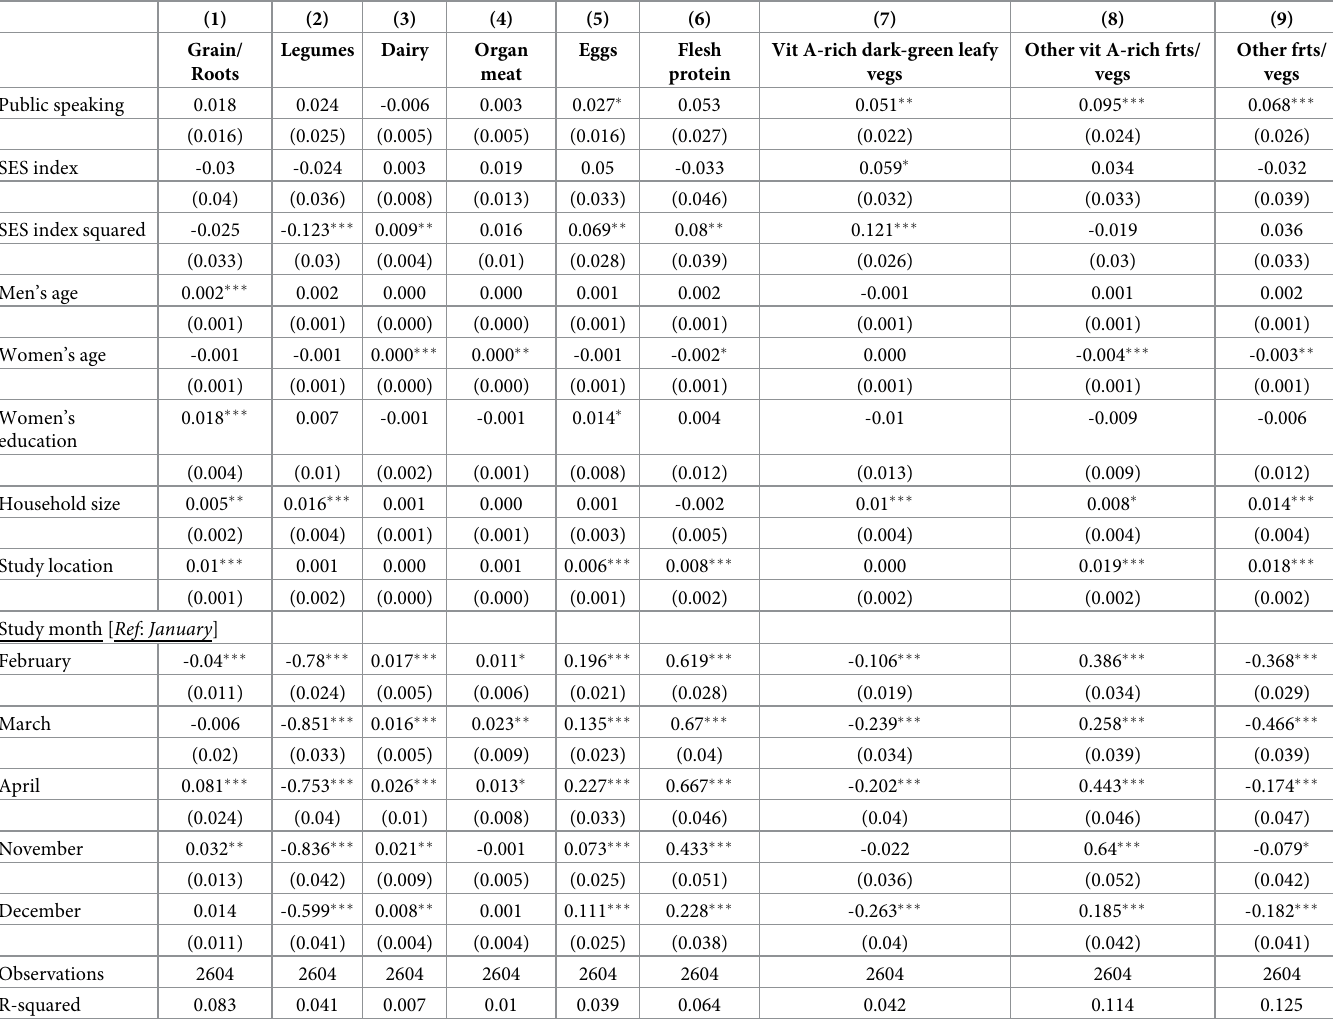
Table 20. LPM regression for food groups consumed–leadership domain (Comfortable speaking in public in � 1